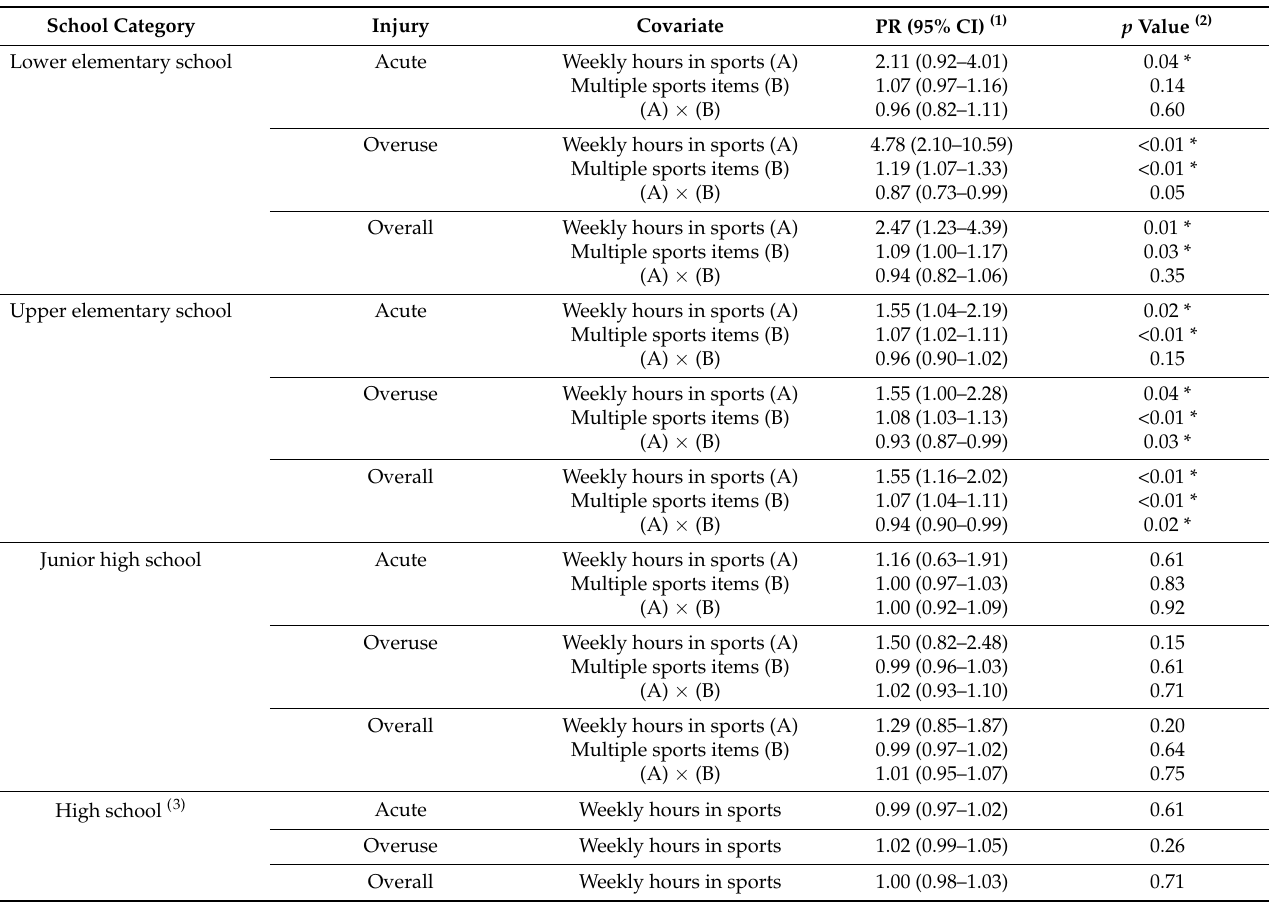
Table 4. Adjusted prevalence ratio with 95% confidential intervals of sports-related injuries according to school categories using three covariates.